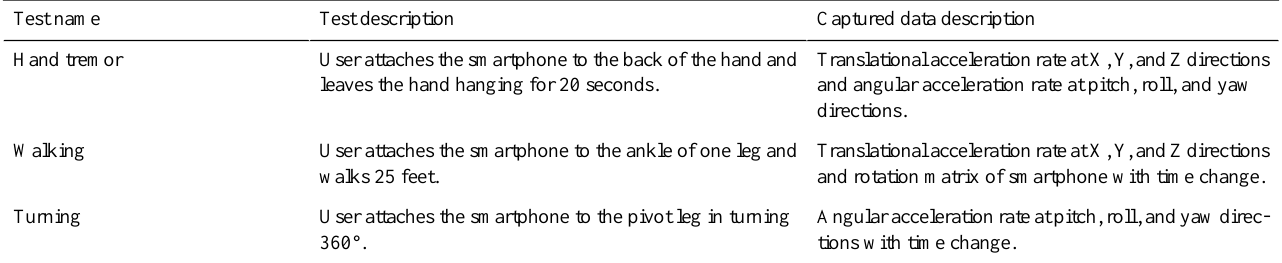
Table 1. Designed motor performance test on PD Dr